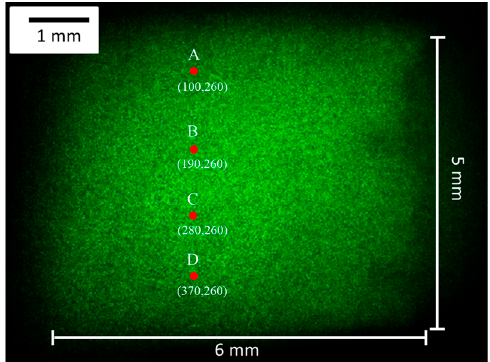
Figure 9. The speckle interferogram collected by CCD.